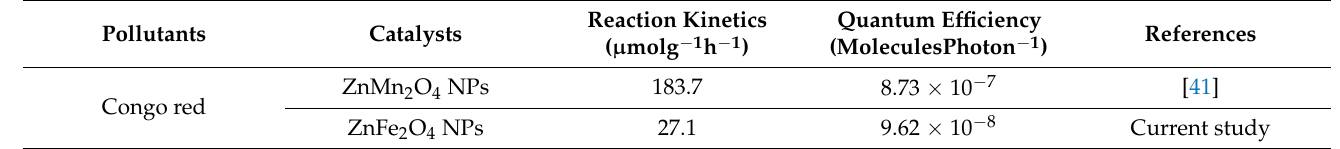
Table 4. Comparative evaluation of the studied photocatalytic system with the reported